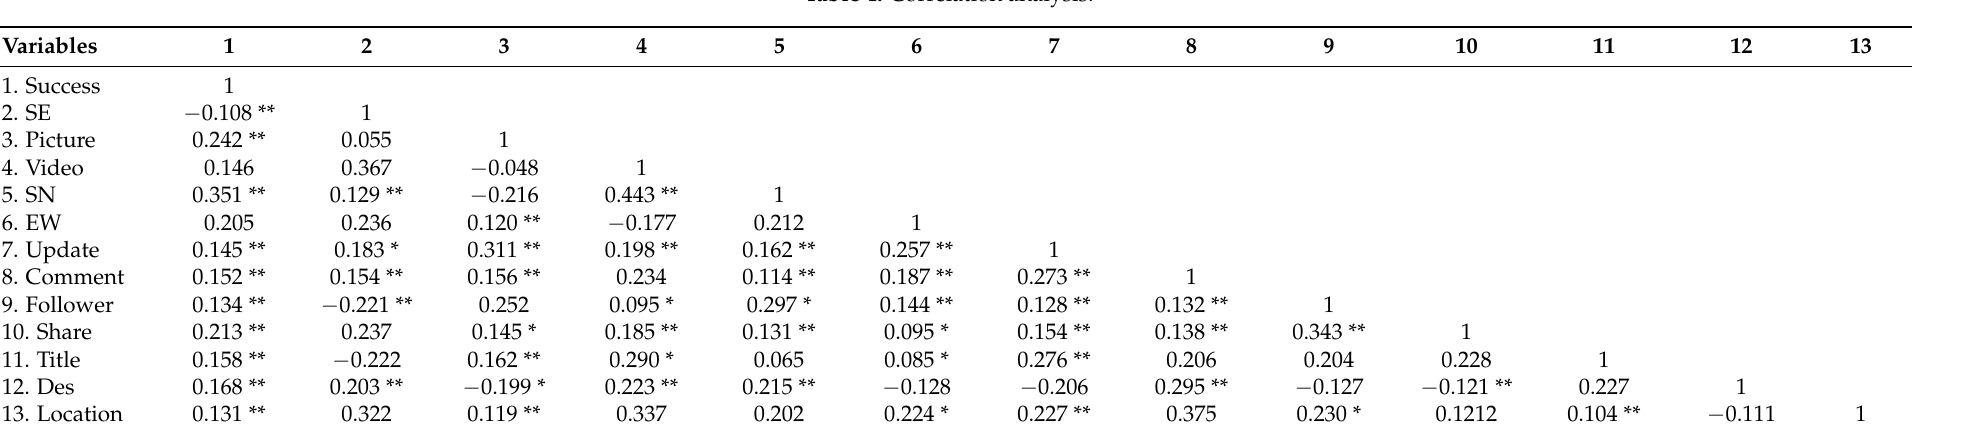
Table 4. Correlation